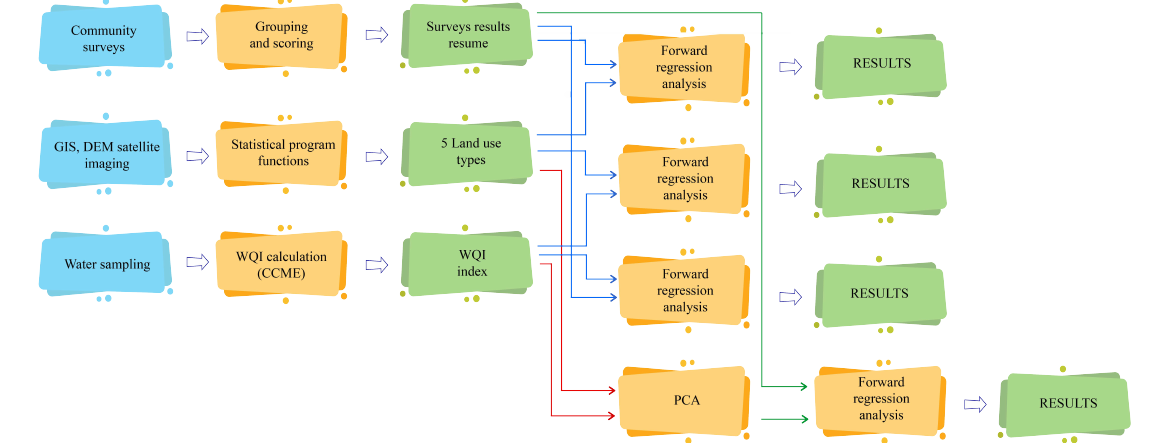
Figure 2. Flow chart showing main data sets, analysis tools used, and results from collection point. The text inside the blue boxes notes each of the three main data sets; text inside the yellow boxes represents the analysis method/s used on each of these data sets, and text inside the green boxes represent results outputs; CCME, Canadian Council of Ministers of the Environment; DEM, Digital Elevation Mode; GIS, geographic information system; PCA, principal component analysis; WQI, water quality index.